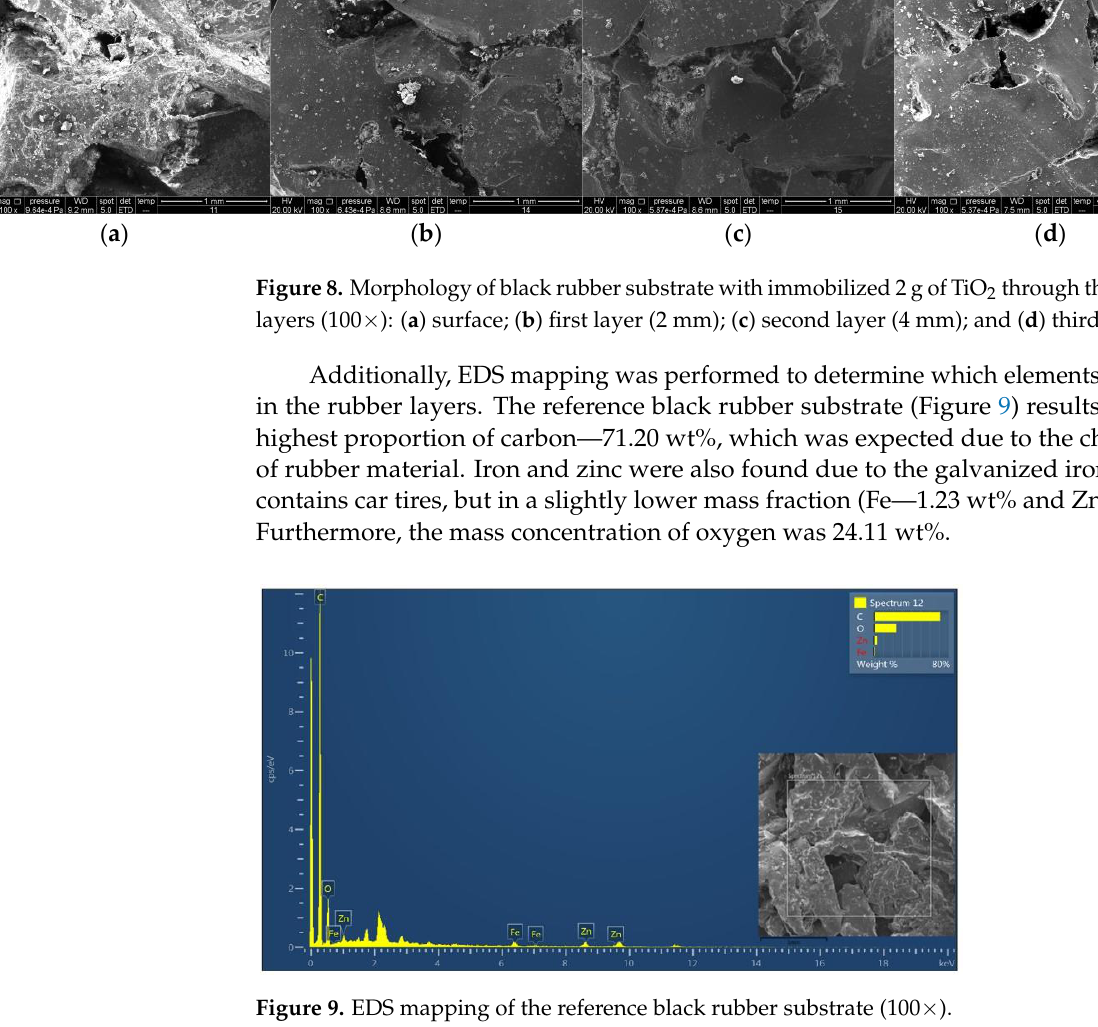
Figure 9. EDS mapping of the reference black rubber substrate (100×).